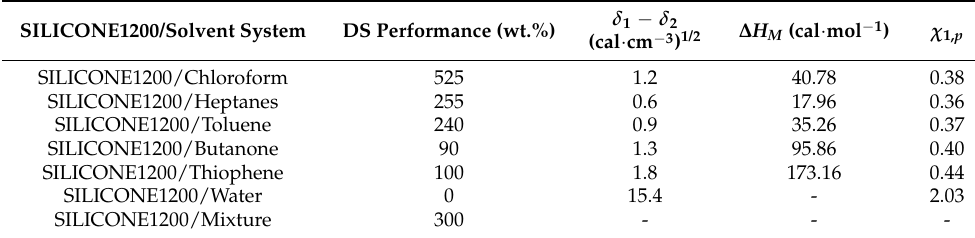
Table 6. Swelling performance, Flory interaction parameters and enthalpy of absorption of the different couples SILICONE1200/solvent calculated from Equations (3) and (4).